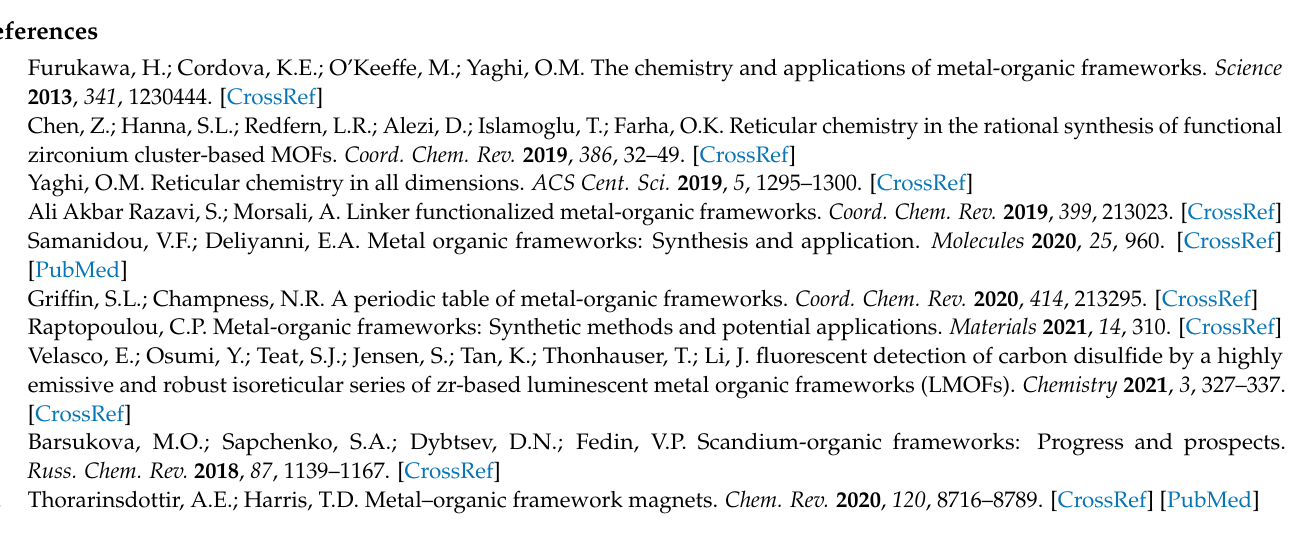
Figure S4: IR spectra for 1 – 3 , Figure S5: TG plots for 1 – 3 , Table S1: Composition of mixed-metal samples 4 – 12 , Figure S6: Experimental PXRD patterns for bimetallic samples, Figure S7: Experimental PXRD patterns for trimetallic samples, Table S2: Luminescence quantum yields for mixed-metal compositions, Figure S8: Luminescence spectra of bimetallic samples 4 – 7 compared to monometallic 1 – 3 , Table S3: CIE 1931 coordinates shown on Figure 2b, Table S4: CIE 1931 coordinates shown on Figure 3, Figure S9: Luminescence spectra of trimetallic samples at different excitation wavelengths, Figure S10: IR spectra for the samples of 3 immersed in liquid nitroaromatics, Figure S11: PXRD patterns for the samples of 3 immersed in liquid nitroaromatics compared to the theoretical one for 3 , Figure S12: Excitation and emission spectra for the samples of 3 immersed in liquid nitroaromatics and cinnamal, Table S5: Quantum yields for the samples of 3 immersed in liquid nitroaromatics and cinnamal compared to as-synthesized 3 , Figure S13: IR spectra for the samples 3 and 3 ⊃ cinnamal , Figure S14: Experimental PXRD pattern for 3 ⊃ cinnamal compared to the theoretical one for 3 , Table S6: Crystal data and structure refinement for 1 – 3